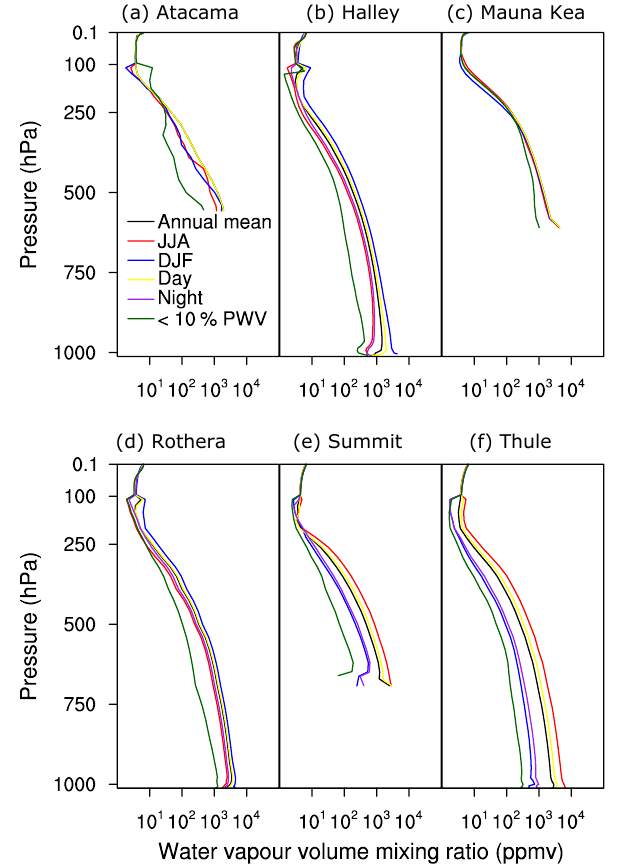
Figure 4. Climatologies of water vapour volume mixing ratio con- structed with spliced radiosonde and ERA-Interim data showing the six scenarios described in Table 2 for all sites (a–f)